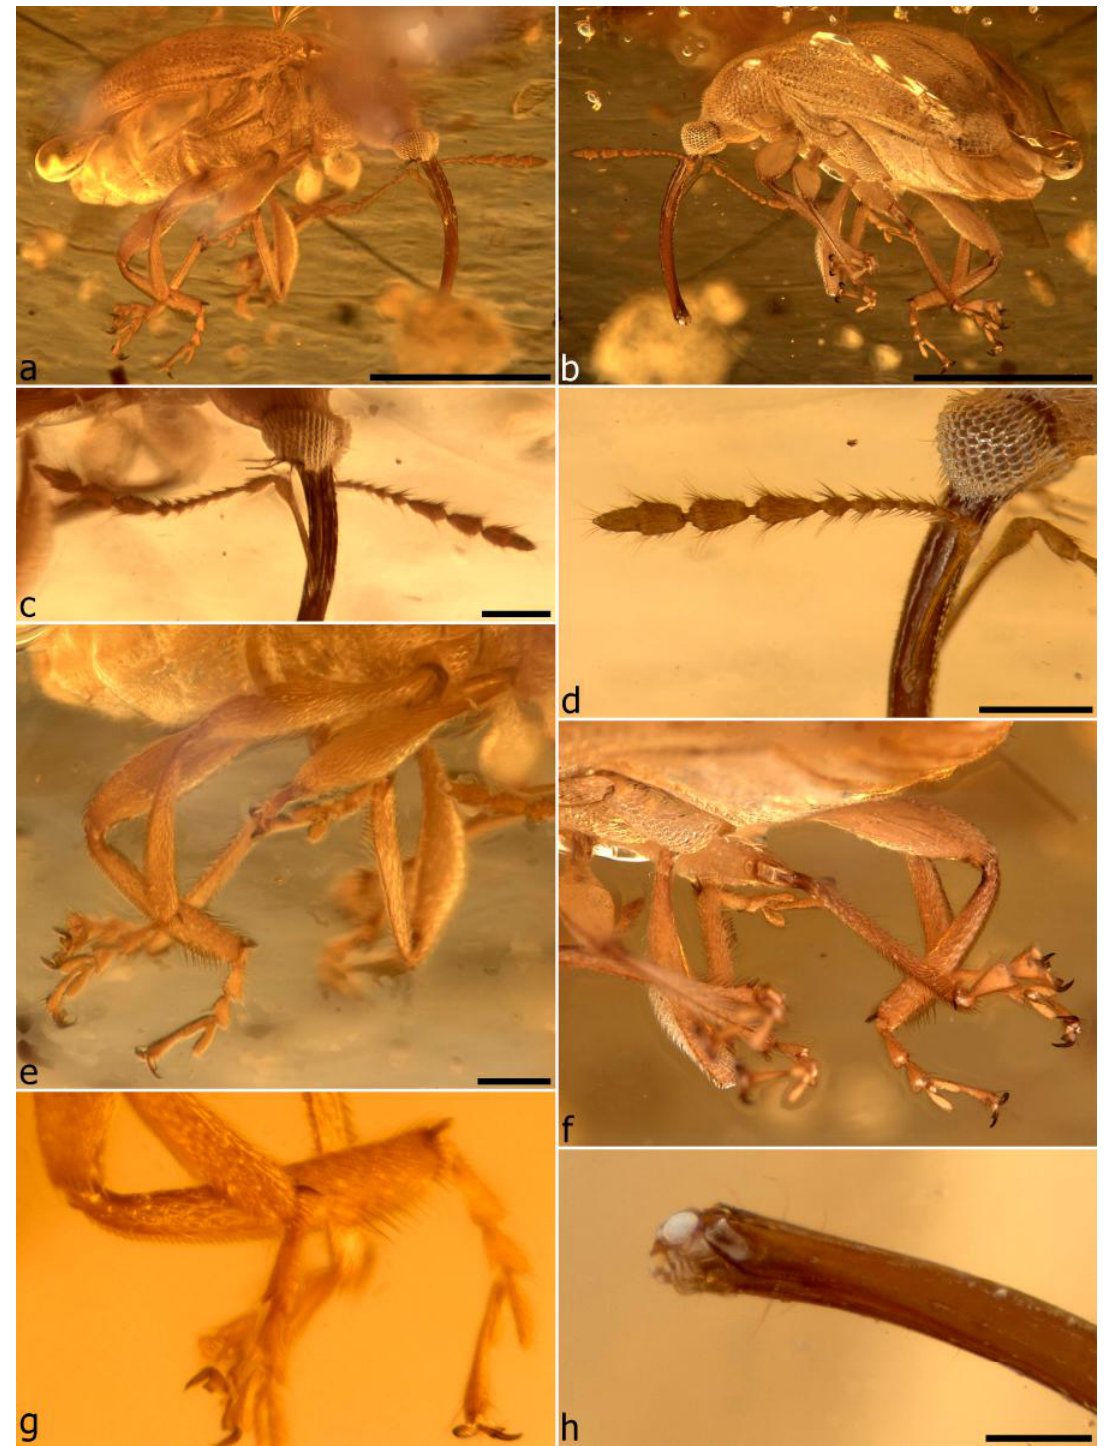
Figure 83. Bowangius sp. 1, Habitus, right lateral ( a ); habitus, left lateral ( b ); head and antennae, right lateral ( c ); eye, antenna and base of rostrum, left lateral ( d ); legs, right lateral ( e ); legs, left lateral ( f ); detail of metatibia and tarsi, right lateral ( g ); detail of rostrum apex showing mandibular articulation socket ( h ). Scale bars: 1.0 mm (a,b); 0.2 mm (c–e); 0.1 mm (h).